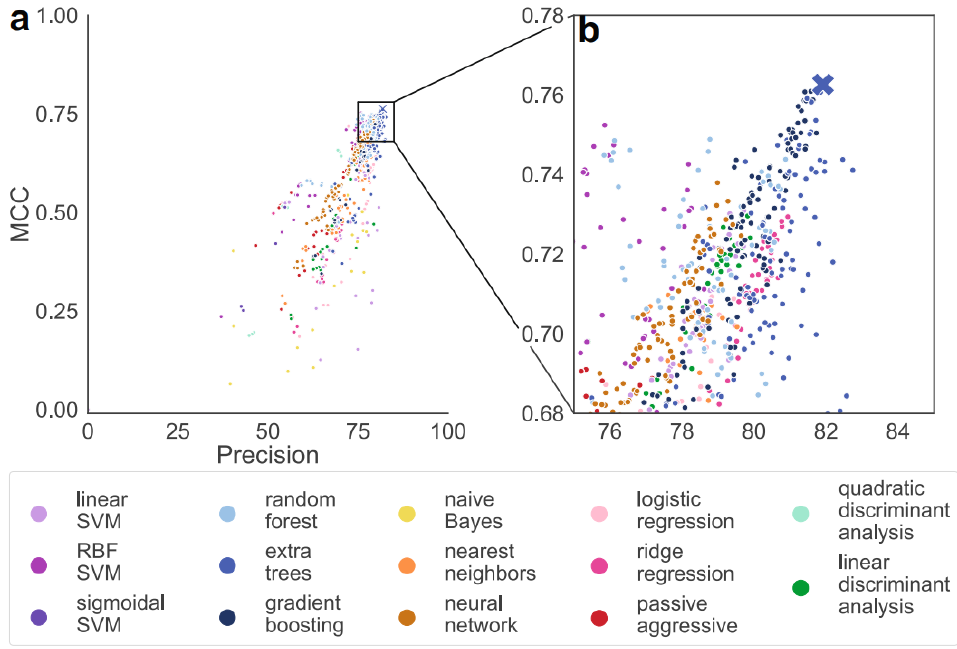
Figure 2. Comparison among candidate models according to precision and Matthews correla- tion coefficient (MCC). The cross represents the optimal model that maximizes both metrics, and is used by the authors for further tests. This figure is reproduced with permission from ref- erence [12] in accordance with a Creative Commons Attribution 4.0 International License (http: //creativecommons.org/licenses/by/4.0/), accessed on 2 February